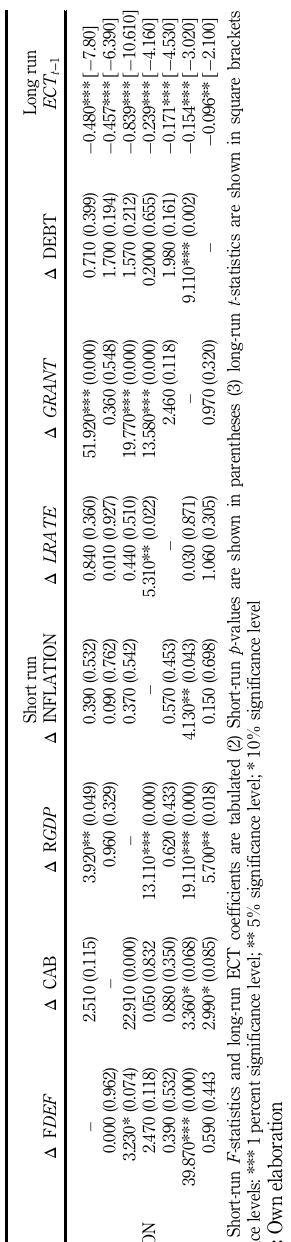
Table 6. Multivariate Granger causality test